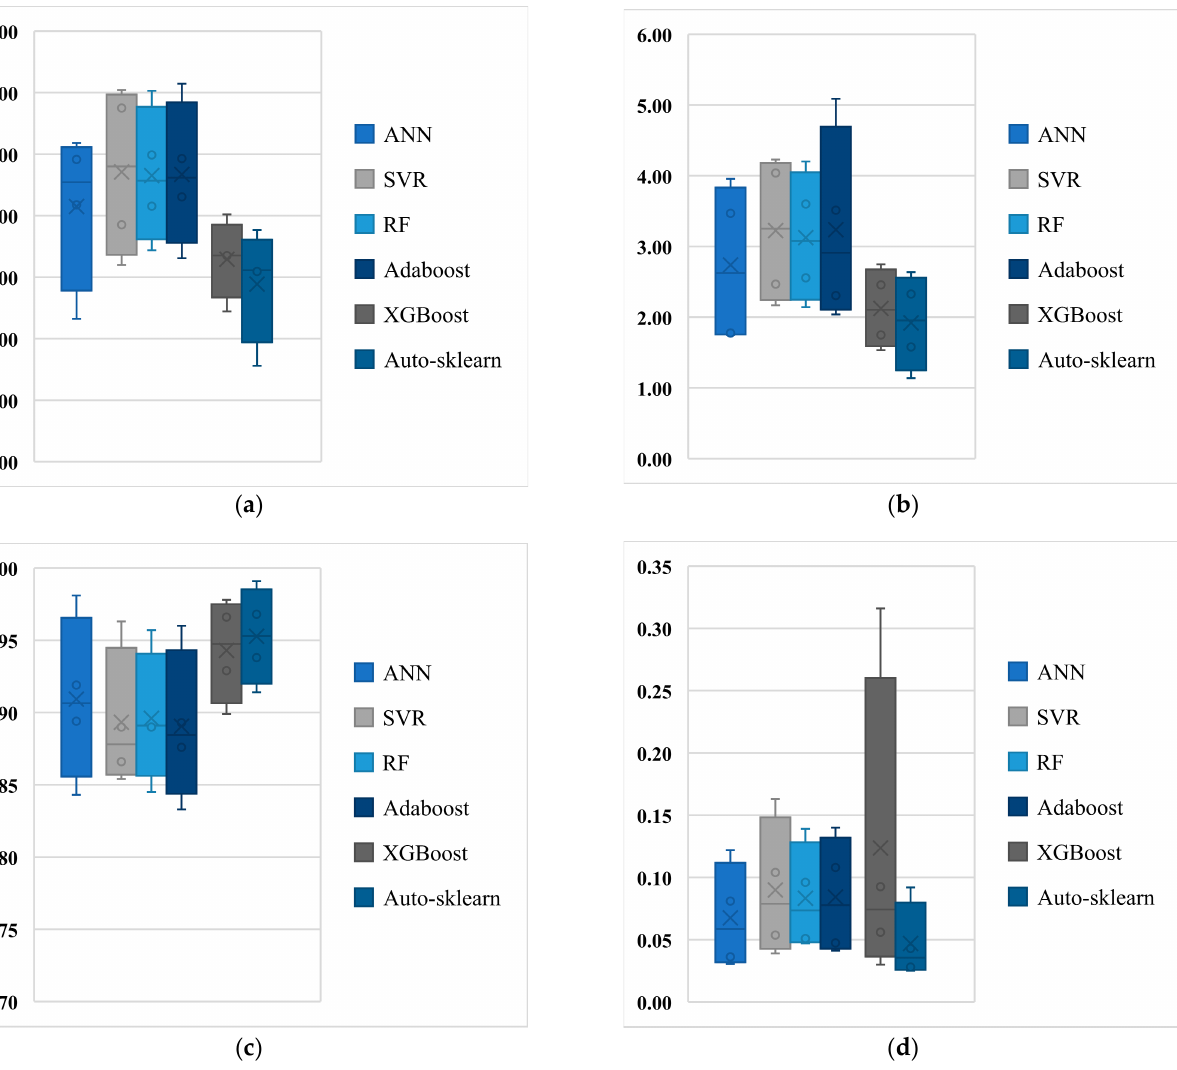
Figure 9. Box plot of four performance evaluation index values for AutoML and ML algorithms. ( a ) RMSE, ( b ) MAE, ( c ) 𝑅 (cid:2870) , and ( d ) MAPE .